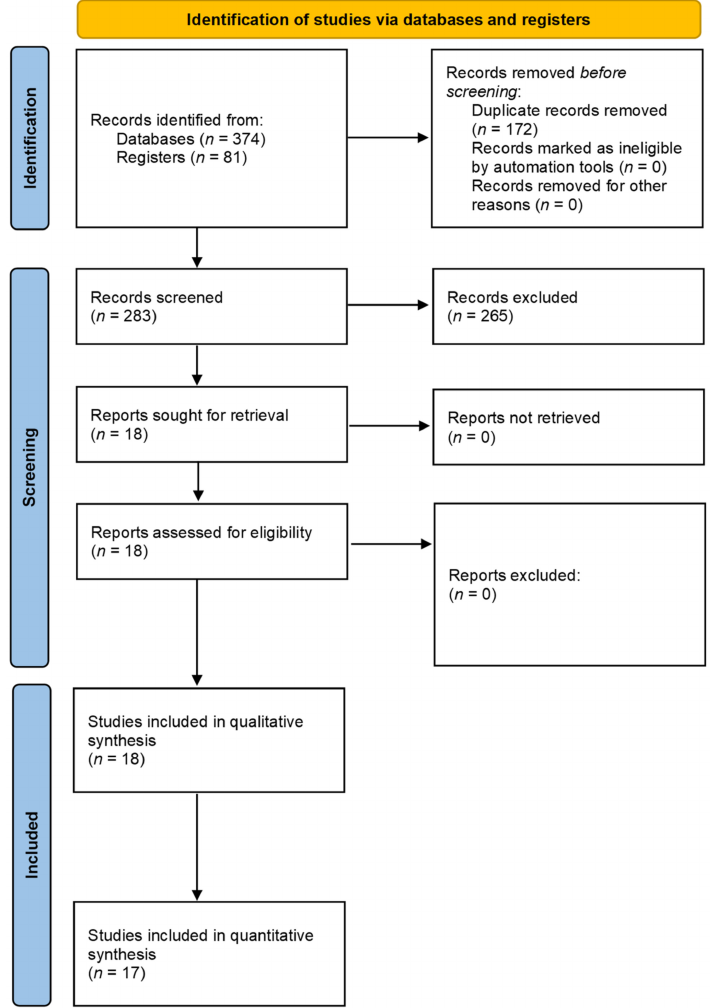
Figure 1. Literature screening process and